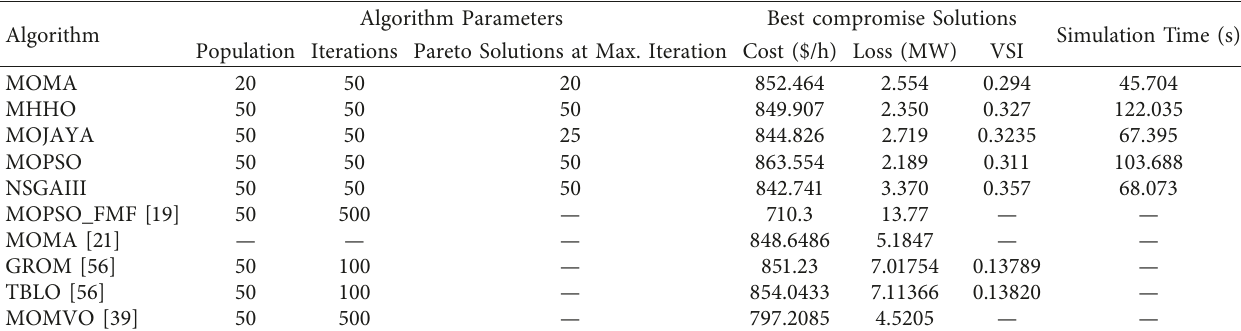
Table 10: Validation of SC-1 Case 1 MOMA results against other algorithms.